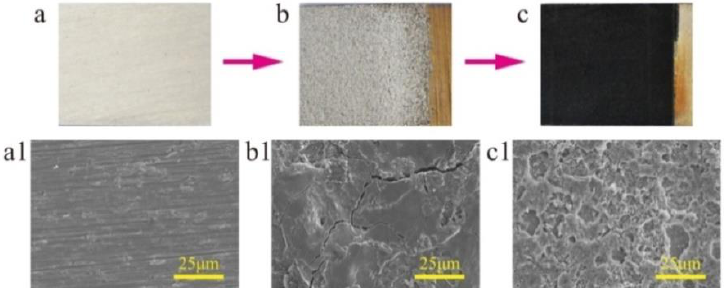
Figure 2. Surface morphology of the titanium surface at each step. ( a ) Original surface, ( b ) EDM surface, ( c ) ECE surface. Scanning electron microscopy (SEM) image of ( a1 – c1 ) is the magnification of (a–c), respectively.